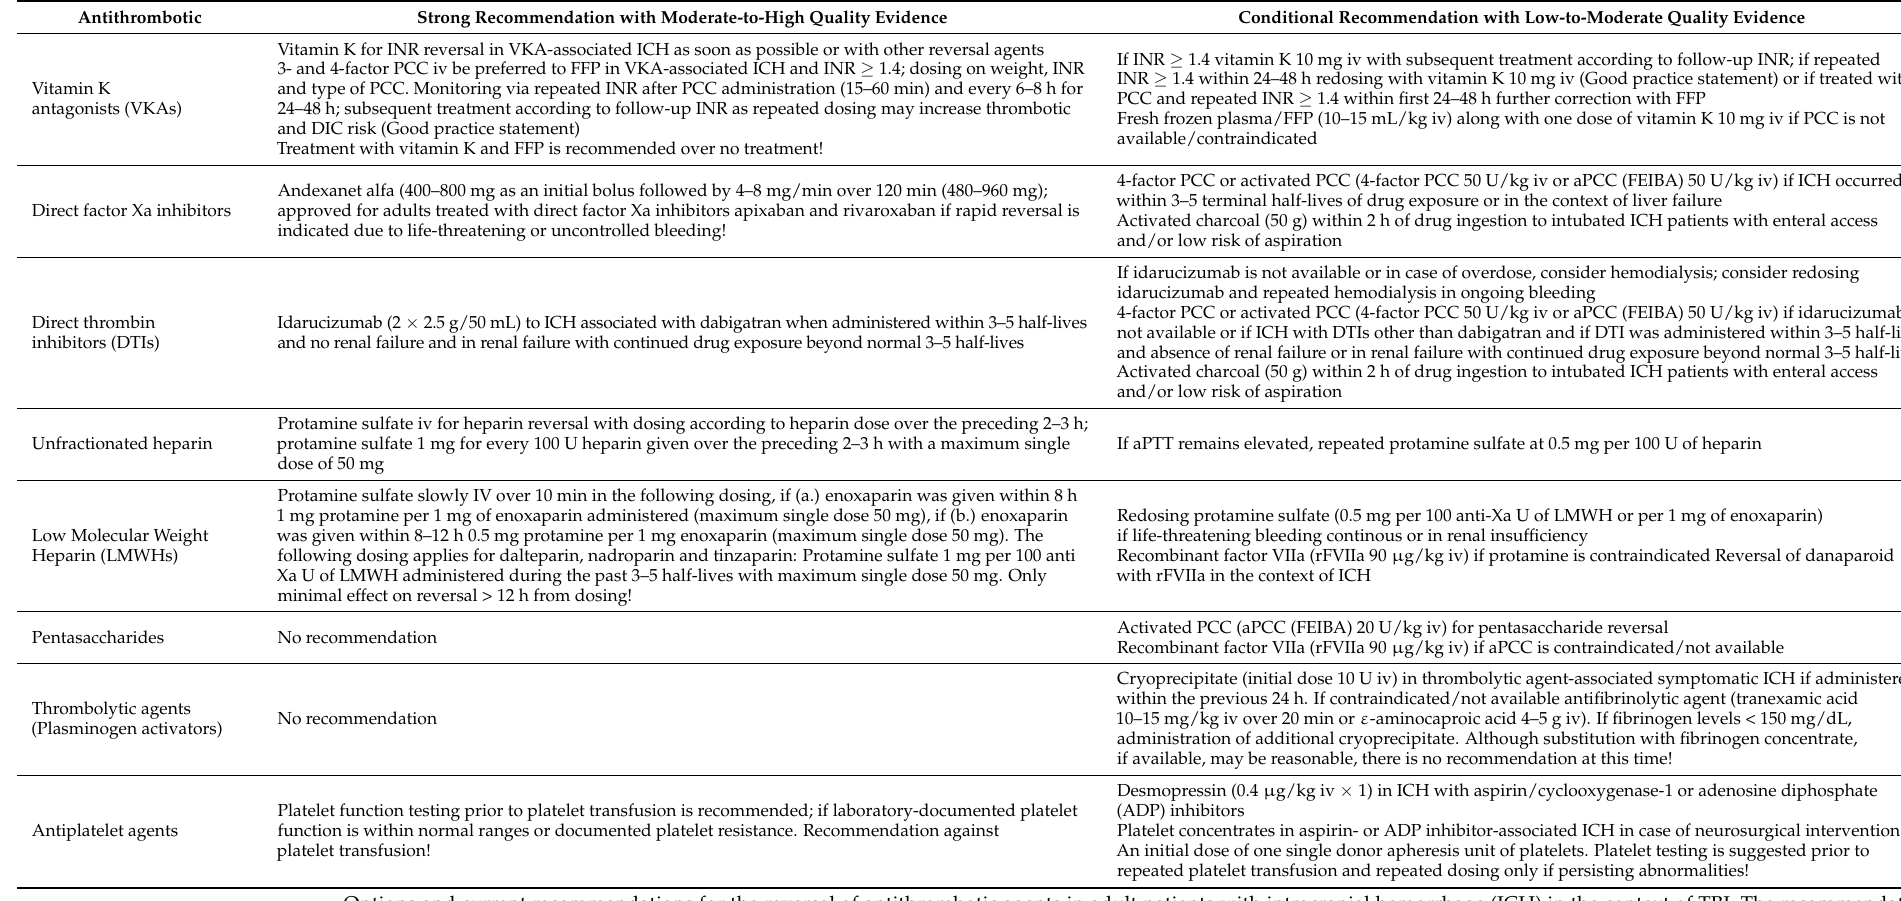
Table 2. Current options for the reversal of antithrombotic agents in adult patients with TBI and traumatic intracranial hemorrhage (ICH). Antithrombotic Strong Recommendation with Moderate-to-High Quality